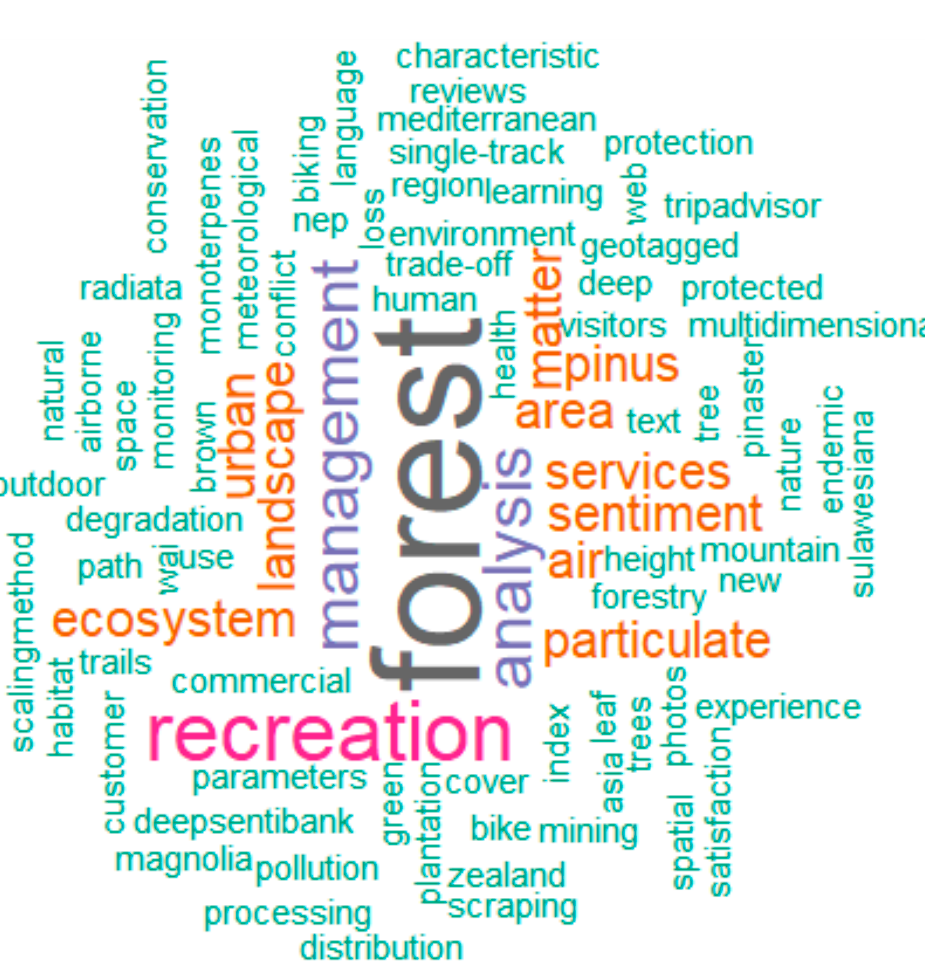
Figure 2. Authors’ affiliation(s) and country (or countries) (right) by paper, with references (left). Data source: [1–10].